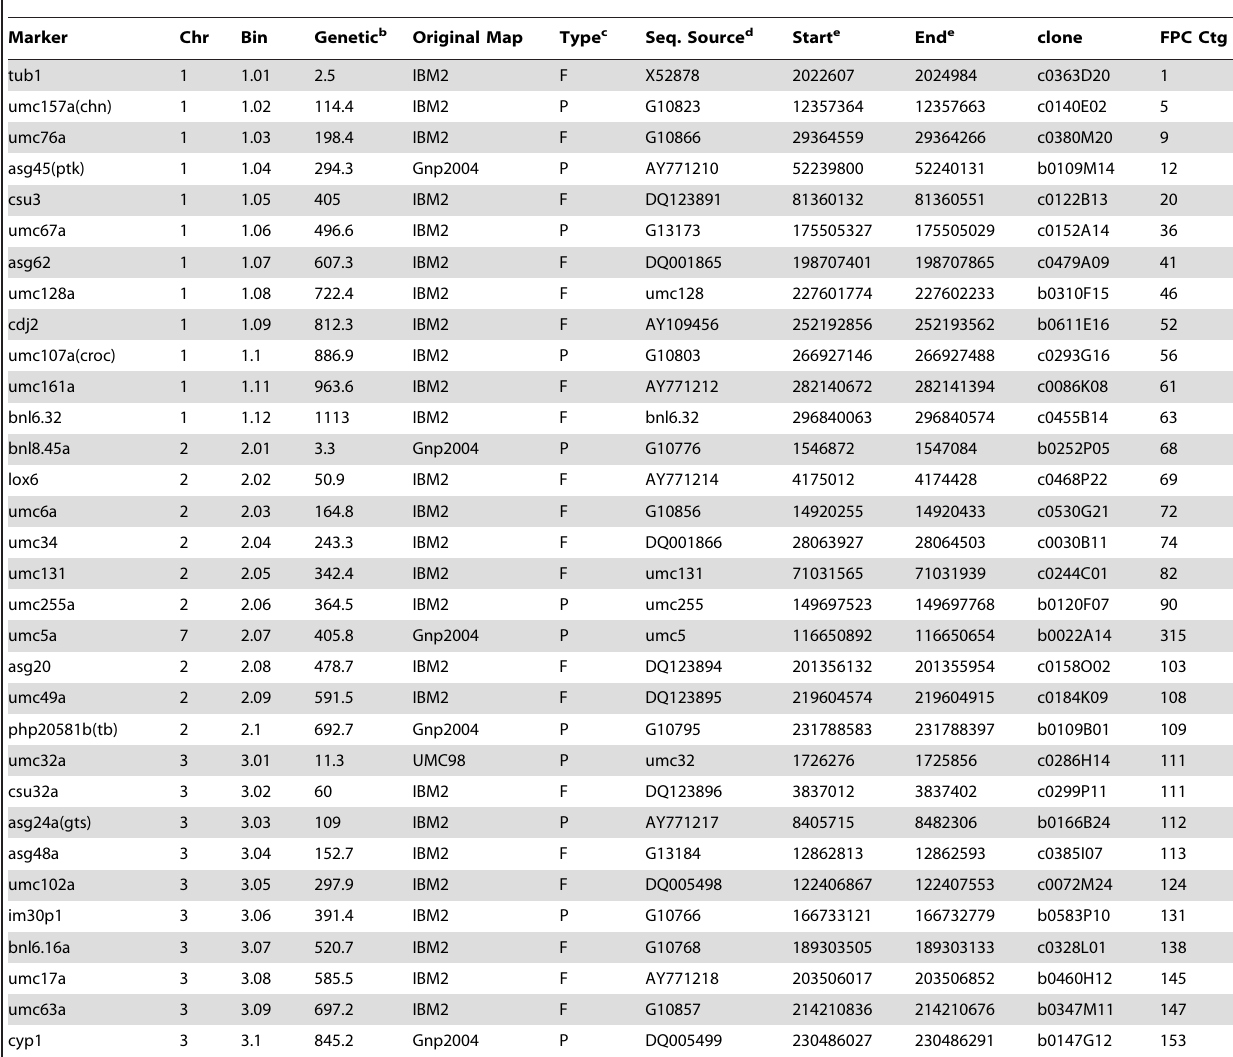
Table 1. Position of bin markers in the B73 physical map and RefGen_v1 a .